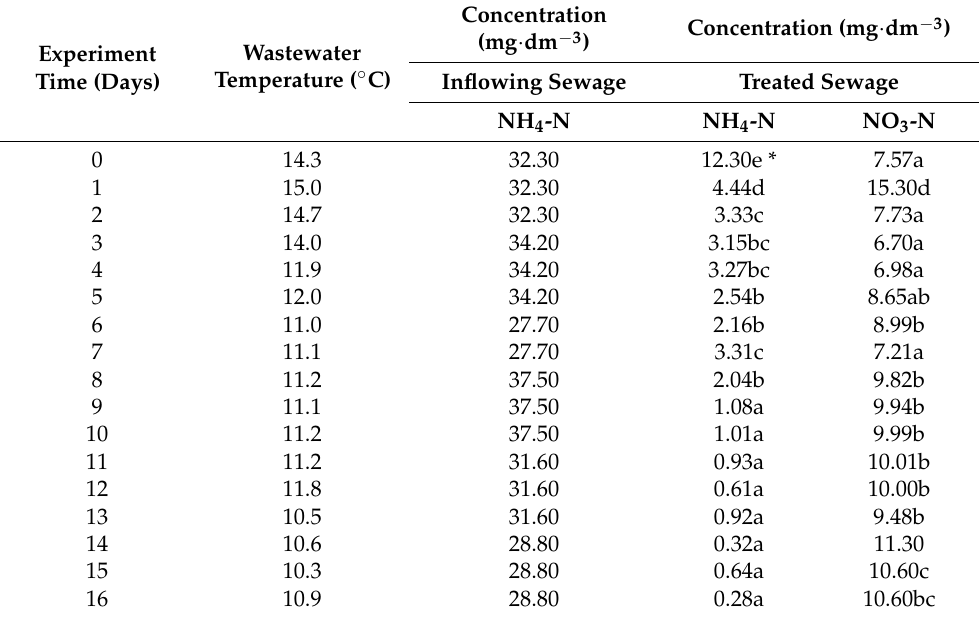
* averages marked with the same letters are not significantly different by Tukey test ( α = 0.05) (one-way ANOVA, taking into account the time of the